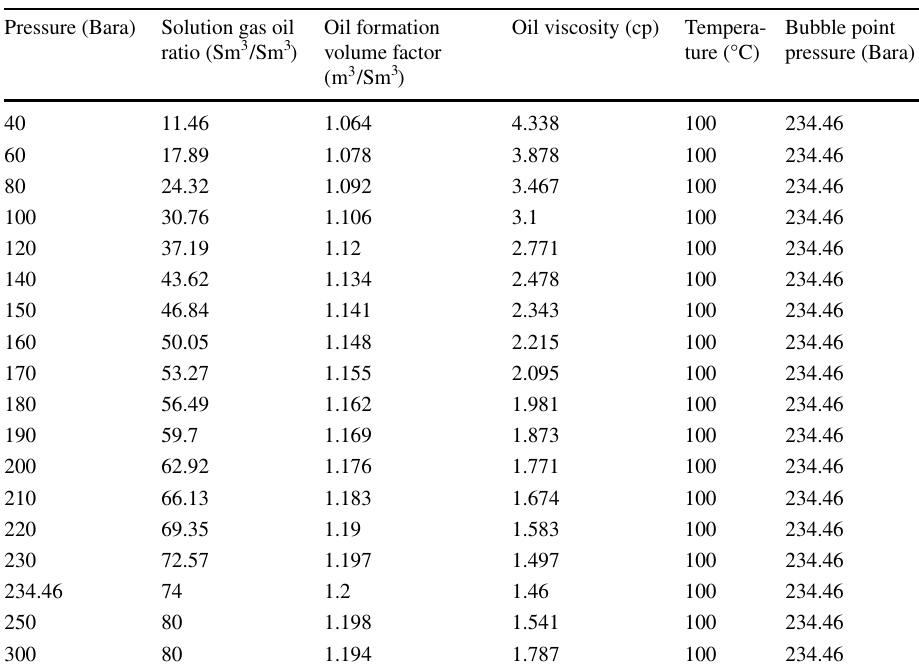
Table 2 Fluid properties measured in the laboratory at different pressure steps to perform PVT